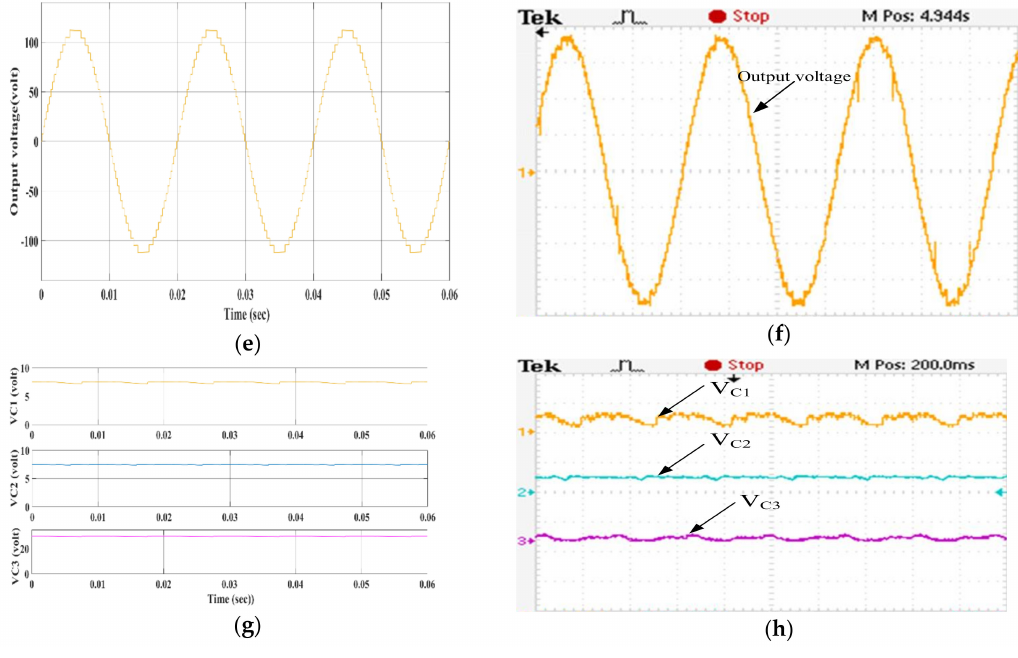
Figure 15. ( a – d ) Switching pulses across switches T 1 , T 3 , T 5 , T 7 , S 1 , S 3 . ( e ) and ( f ) Output Voltage of 31 leVel inVerter 31.25 V / diV. ( g ) and ( h ) Voltage across capacitors C 1 , C 2 , and C 3 .